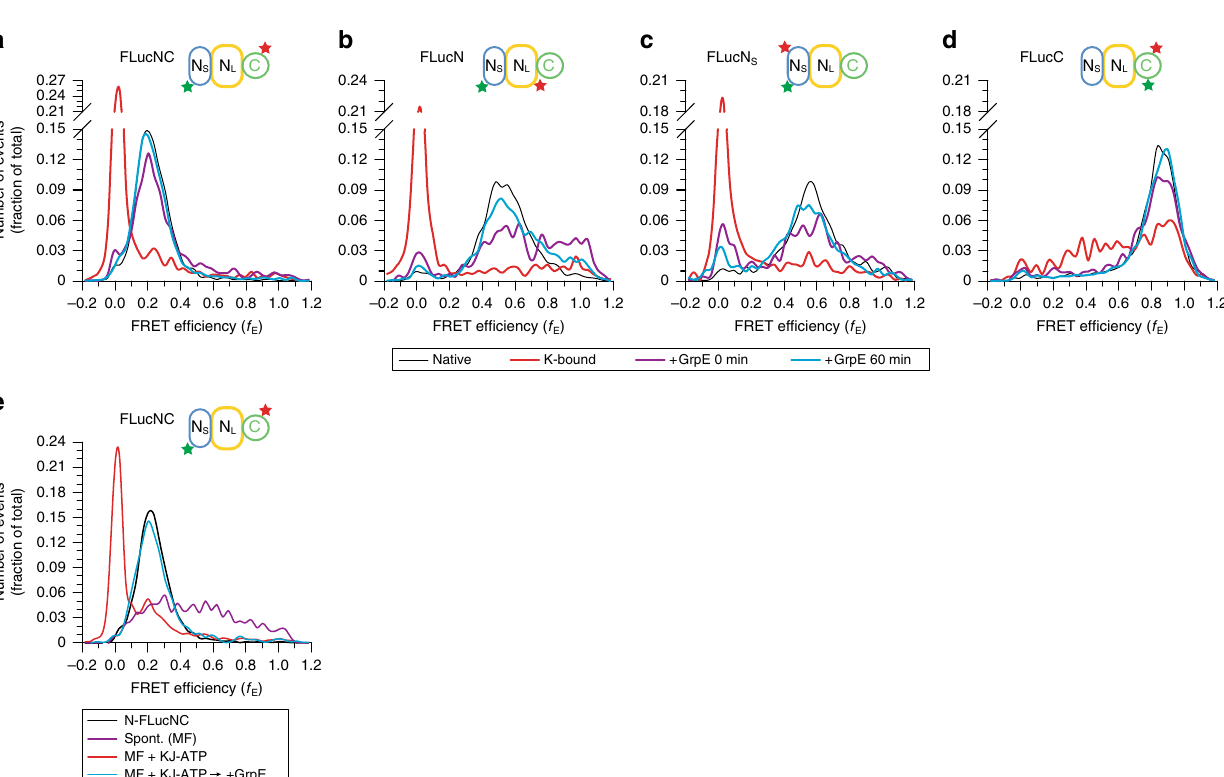
Fig. 4 KJE reverses misfolding and commits bound protein to fast folding. a – d spFRET ef fi ciency histograms measured during KJE-ATP assisted folding of FLucNC ( a ), FLucN ( b ), FLucN S ( c ) or FLucC ( d ). GuHCl-denatured FLuc was diluted to 50 pM in buffer containing 0.3 µ M DnaK, 0.1 µ M DnaJ, 5 mM ATP and 50 µ M PBT, and the f E distribution of DnaK-bound FLuc was recorded, followed by initiation of folding with 0.5 µ M GrpE. spFRET was recorded for 15 min either immediately (0 min) or after 60 min of folding. Representative measurements of three independent repeats are shown. e KJ-ATP converts compact, misfolded (MF) intermediates of FLuc to the DnaK-bound, expanded state. GuHCl-denatured FLucNC was diluted to 50 pM in buffer containing ATP and PBT, and the distance between N- and C-domains probed by spFRET as in ( a ). KJ-ATP were added after 1 h to generate DnaK-bound FLuc, followed by GrpE to initiate folding. Representative measurements of three independent repeats are shown. Spont., spontaneous folding. Source data are provided as a Source Data fi